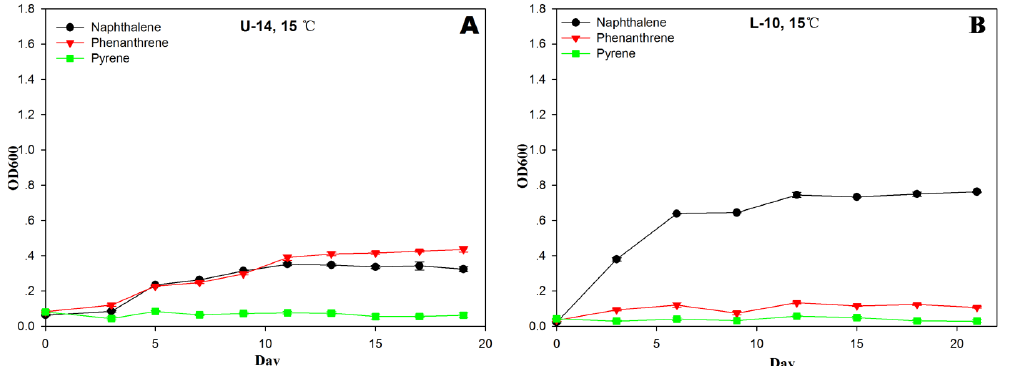
Figure 7. Growth curves of strains 15BN12U-14 and 15BN12L-10 using individual PAHs as the sole carbon and energy source in ONR7a medium. (a, b) Strain U-14 and L-10 cultivated at 15 ◦ C, respectively. OD 600 denotes optical density at